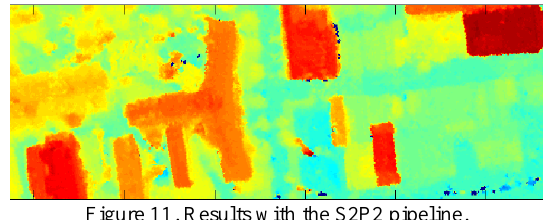
Figure 11. Results with the S2P2 pipeline.